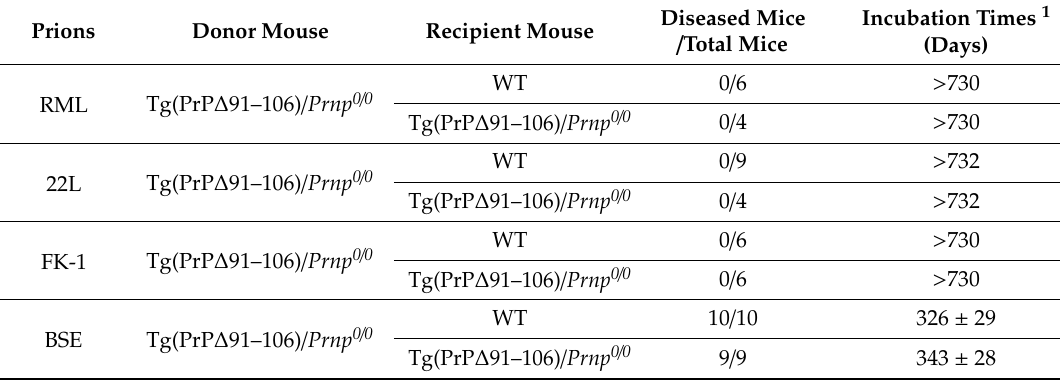
Table 2. Secondary transmission of PrP Sc ∆ 91–106 prions in WT and Tg(PrP ∆ 91–106) / Prnp 0 / 0 mice. Prions Recipient Mouse